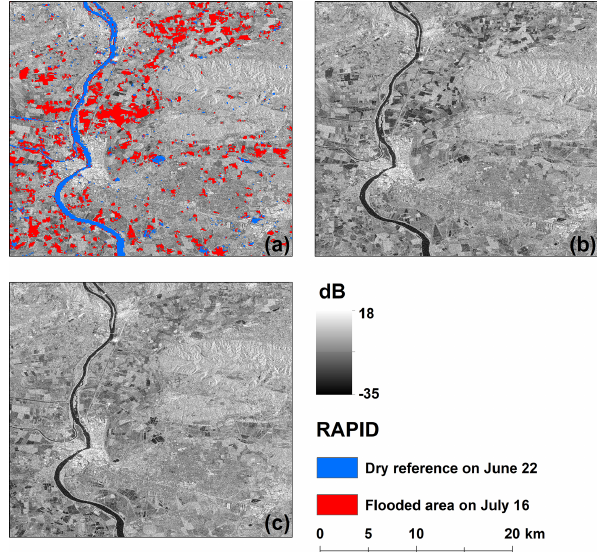
Figure 3. (a) RAPID flood map; (b) Sentinel-1 SAR image in VH polarization sensed on 16 July; (c) Sentinel-1 SAR image in VH polarization sensed on 22